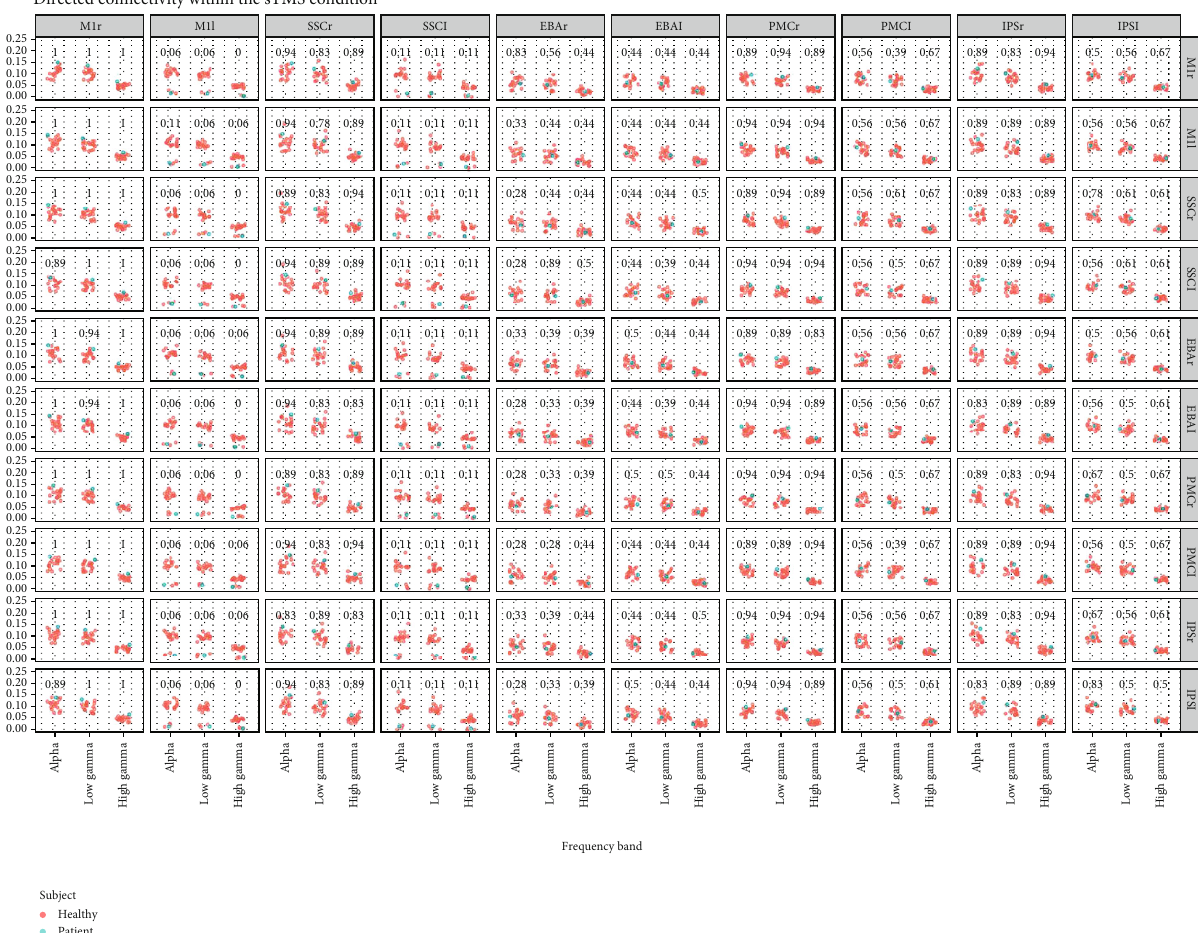
Figure 3: Directed connectivity ( ff DTF) after sham transcranial magnetic stimulation. The values show the percentile of the patients ’ data within the data of the control group (from 0 to 1). M1: primary motor cortex; S1: primary somatosensory cortex; EBA: extrastriate body area; PMC: premotor cortex; IPS: intraparietal sulcus; r: right; l: